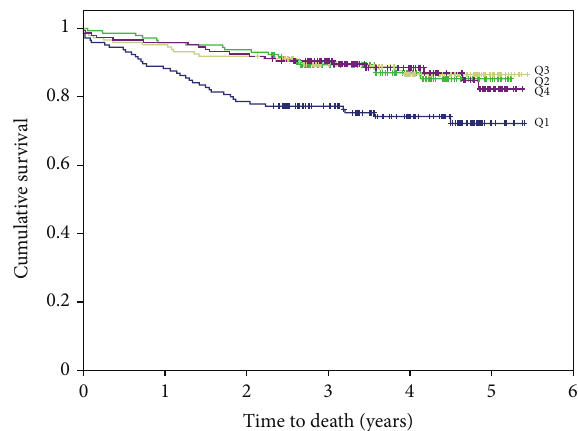
Figure 3: Kaplan-Meier plots for the cumulative risk of all-cause mortality in men in the 25(OH)D quartiles.